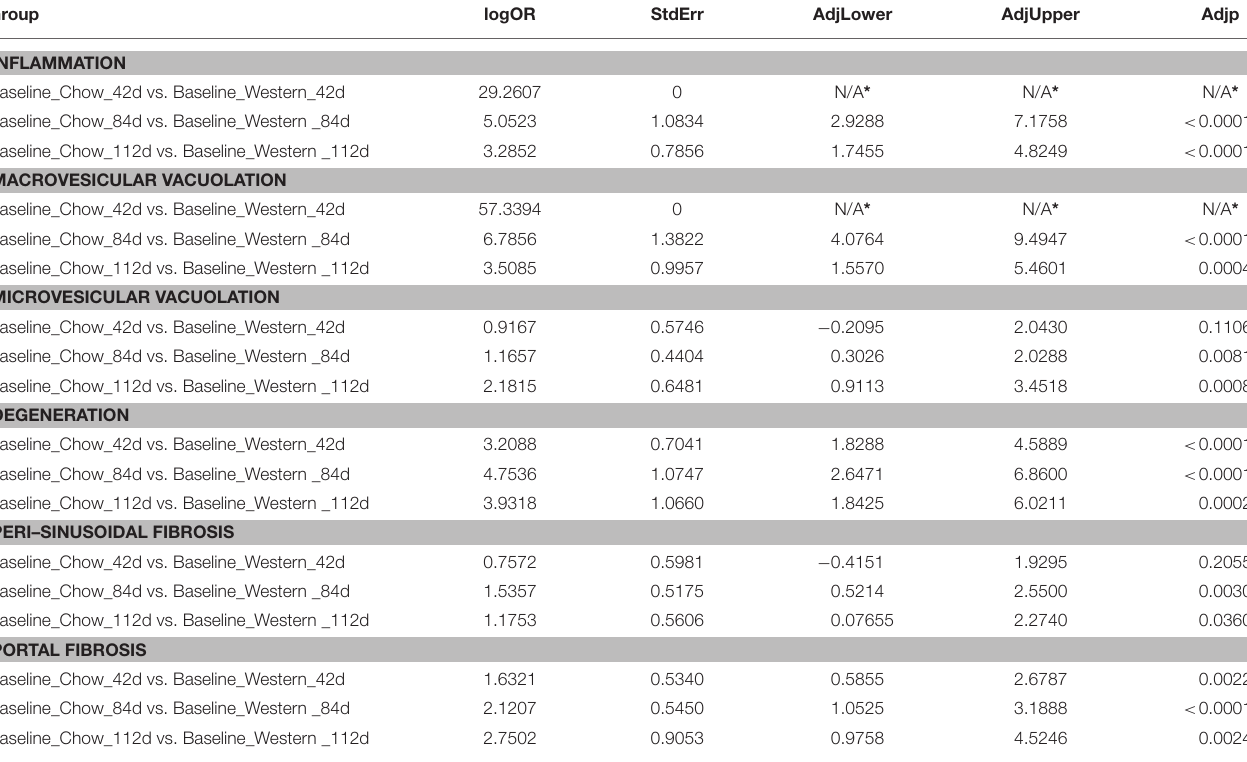
TABLE 4 | Statistical analysis of regression study (Chow vs. Western). Group logOR